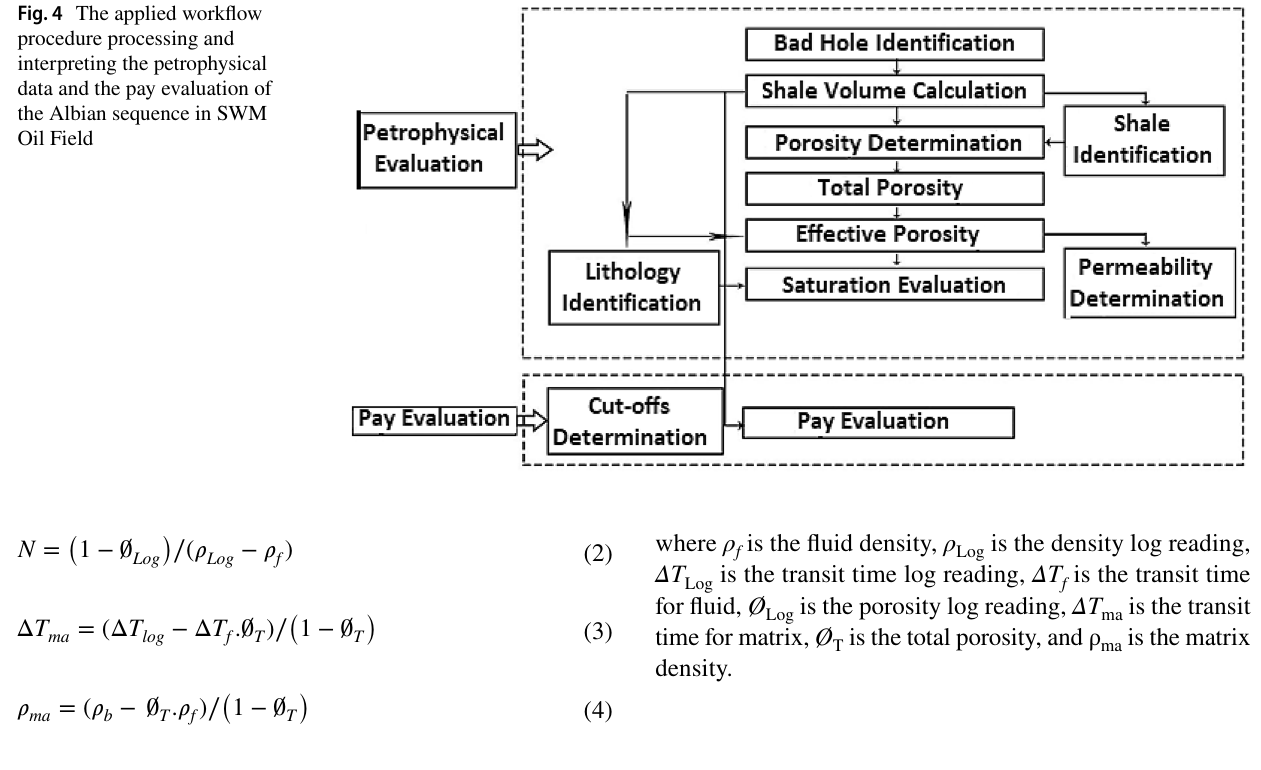
Fig. 4 The applied workflow procedure processing and interpreting the petrophysical data and the pay evaluation of the Albian sequence in SWM Oil